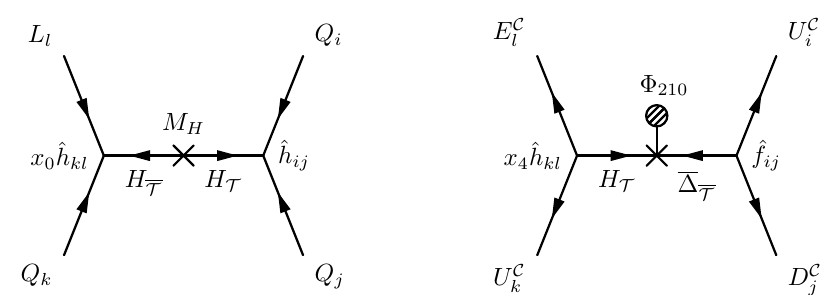
Figure 1 . Examples of super(cid:12)eld diagrams that lead to proton decay in this model. The hats on the couplings indicate mass basis, and the parameters x i contain the triplet mixing information unique to the speci(cid:12)c pairing of couplings present in each diagram (see below). Note that the magnitude constraints on the f and g required by the texture ensatz, ij ij as well as phenomenological constraints on the threshold corrections [76], prevent a